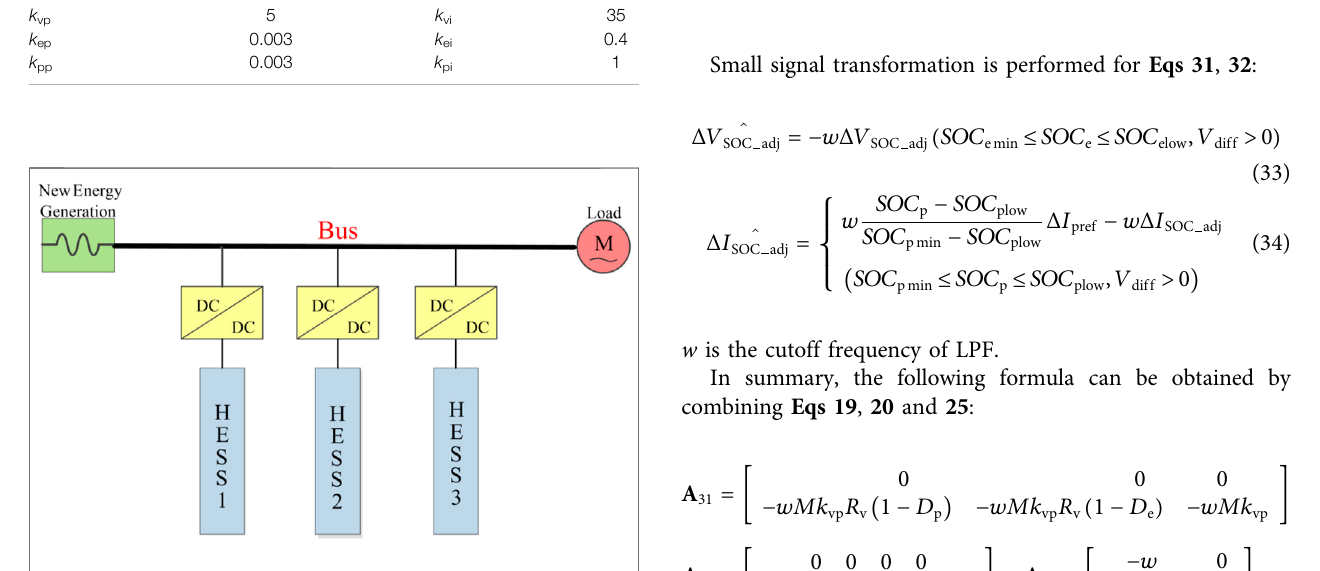
FIGURE 10 | The overall simulation